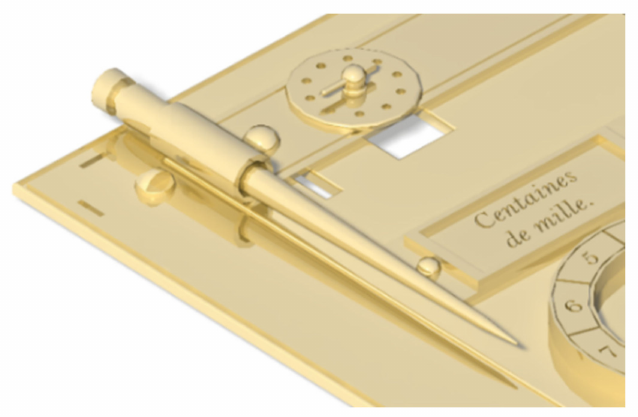
Figure 21. Stylus located in the cylindrical cavity of the sliding panel.